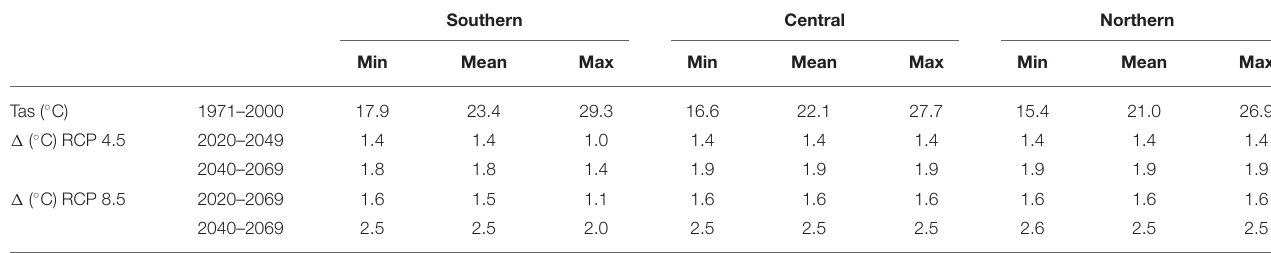
TABLE 1 | The historic annual mean, minimum, and maximum surface air temperatures (Tas) in the three regions of Malawi for the 1971–2000 period, and the Regional Climate Model (RCM) ensemble mean projected change ( 1 ) in temperature for the 2035 (2020–2049) and 2055 (2040–2069) climate periods under the Representative Concentration Pathway (RCP) 4.5 and 8.5 scenarios.